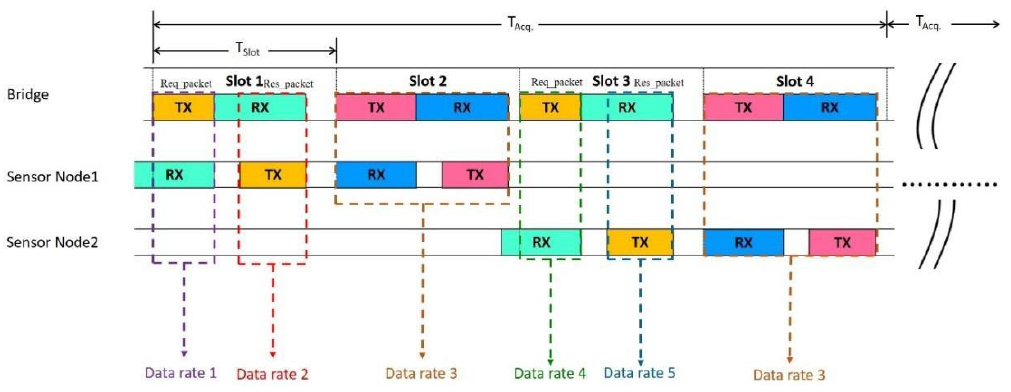
Figure 2. Schematic diagram of TDMA.